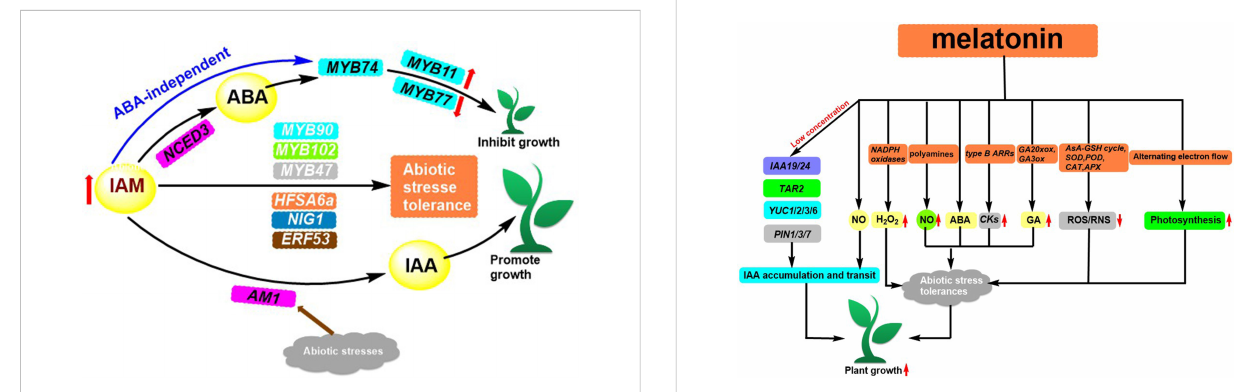
FIGURE 3 IAM accumulation-mediated transcriptional activation of MYB74 and its conversion to IAA regulates plant growth.